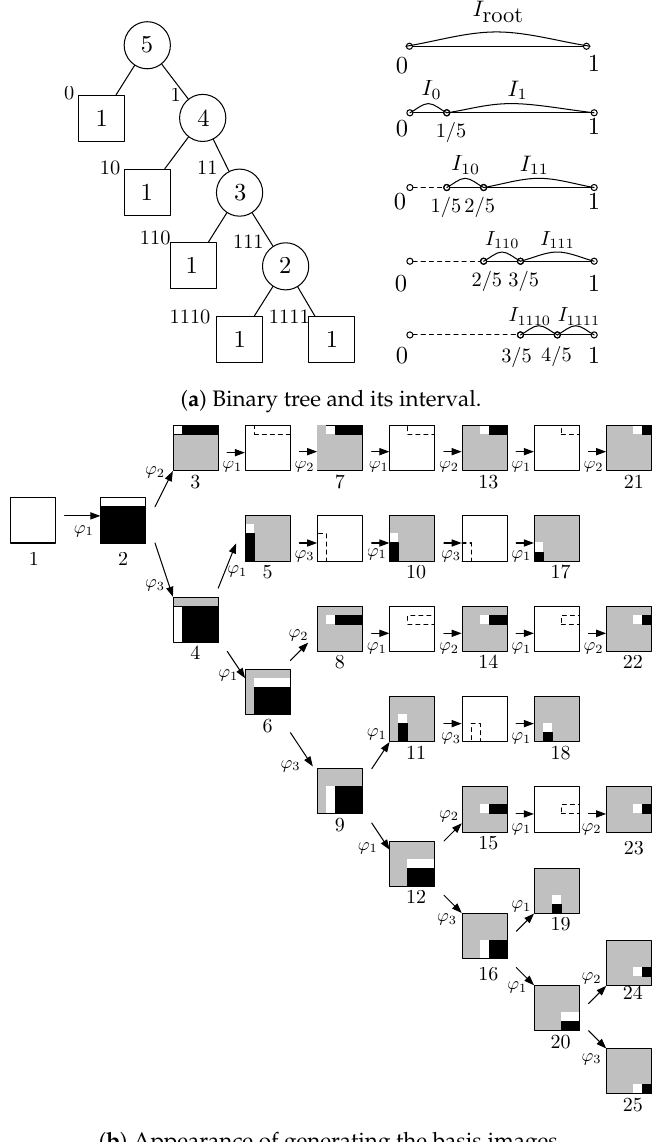
Figure 5. An example of OTSHT basis images based on a logarithmic binary tree having five